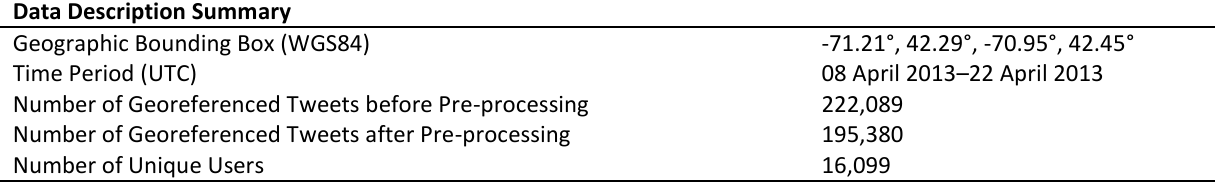
Table 1. Dataset description summary.